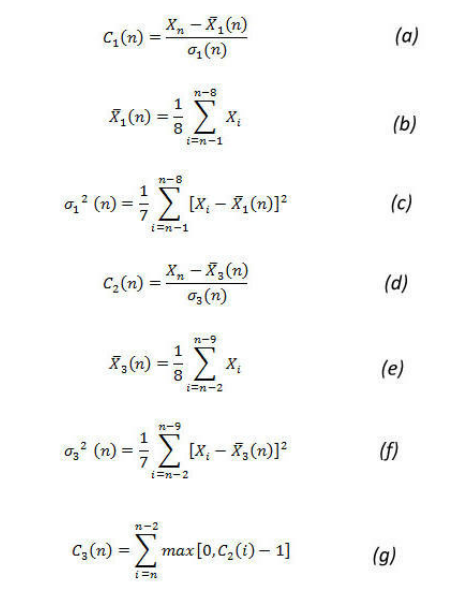
Figure 1. Early Aberration Reporting System (EARS) algorithm equations. C 1 = cumulative sum (CUSUM) score of C1 algorithm, C 2 = CUSUM score of C2 algorithm, C 3 = CUSUM score of C3 algorithm, sigma = standard deviation, X-bar = mean number of cases, X n = number of cases in current time interval. Subscripts refer to a specific variable being